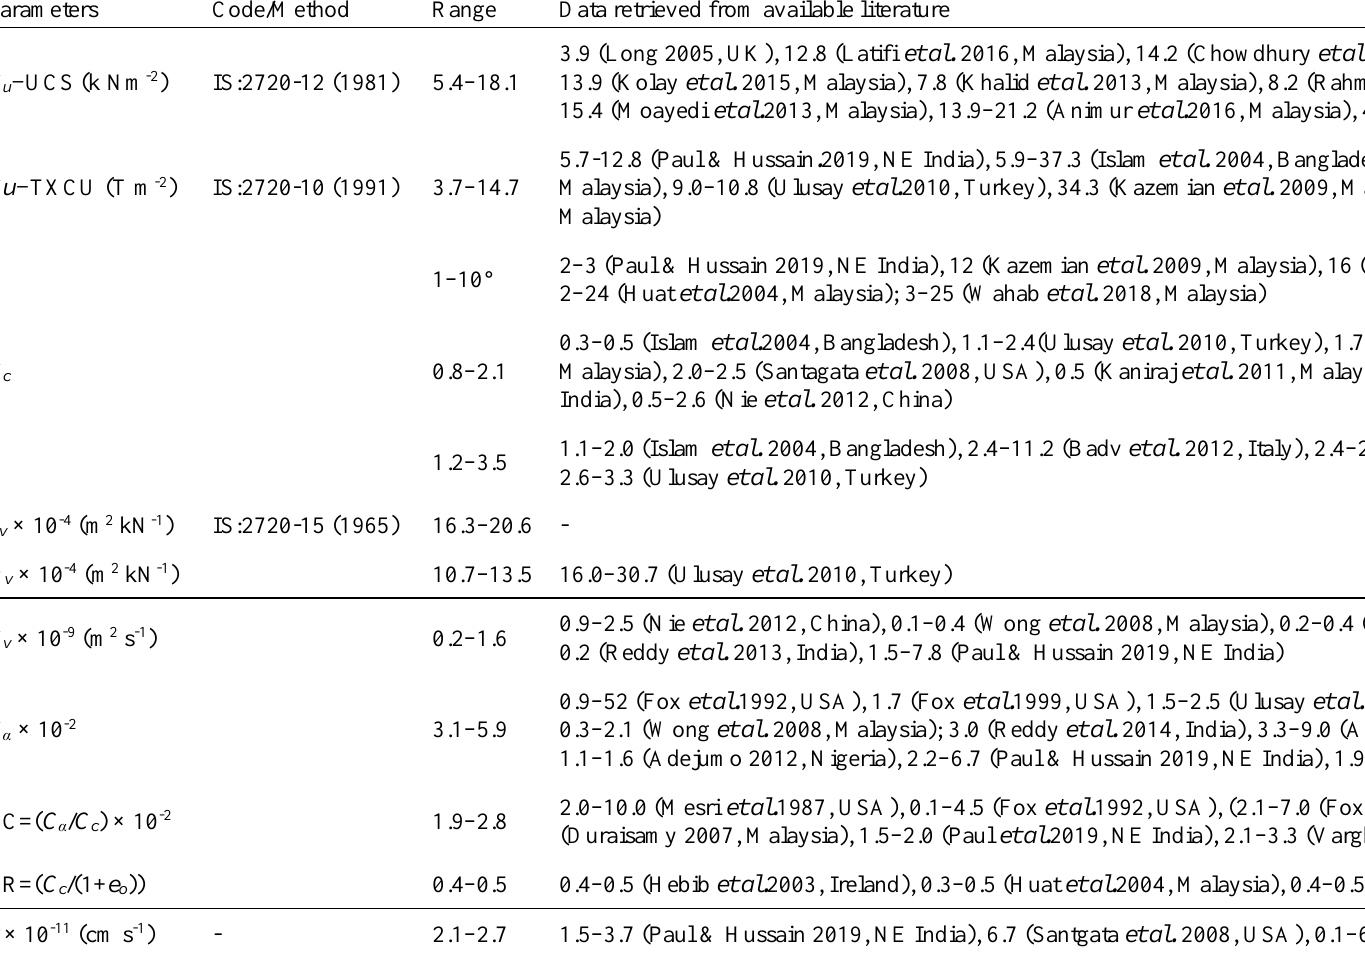
Table A2. Static engineering parameters of Agartala peat. C u = cohesion, Ø = angle of internal friction, C c = coefficient of compression, e = void ratio, G p = specific gravity, γ b = bulk density, LL = liquid limit, , a v = coefficient of compressibility, m v = volume compressibility, C v = coefficient of consolidation, C α = secondary consolidation, RC = ratio of compression, CR = compression ratio, k - permeability